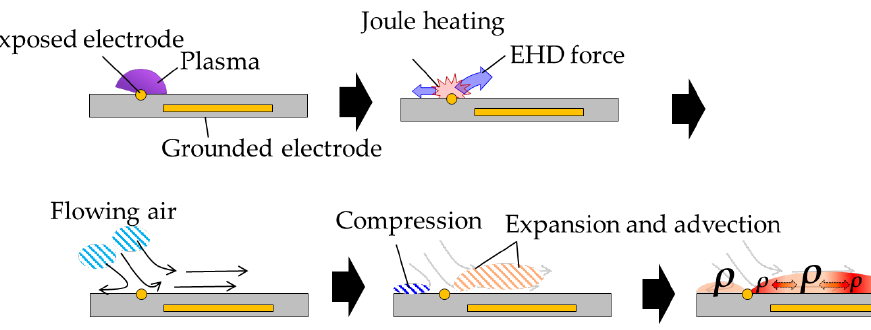
Figure 18. Forming mechanism of the flow and density field of the